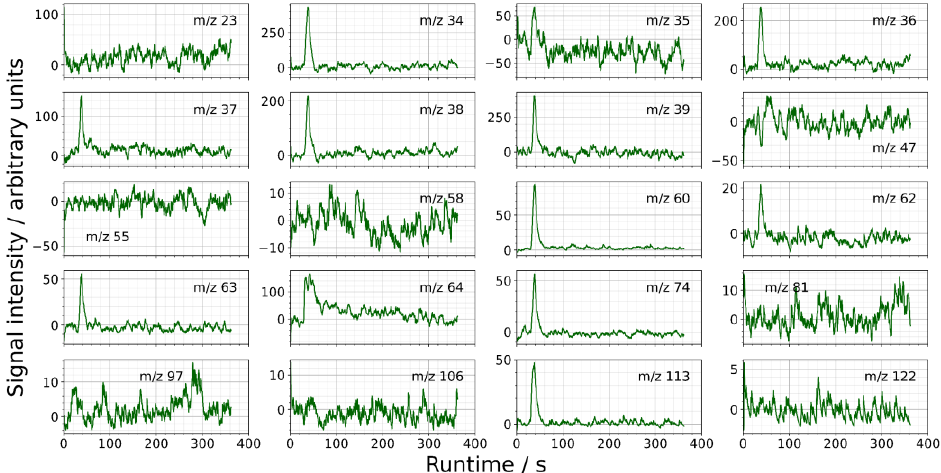
release was observed.